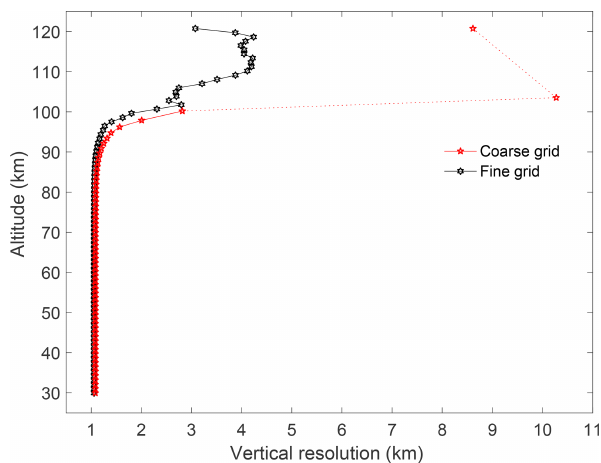
Figure 16. The PCL vertical resolution for 12 May 2012 on the fine and coarse grid. The vertical resolution is similar up to 85km on both grids. Above this height the vertical resolution decreases until it is 10km in resolution above 100km altitude (dotted red line). We consider 100km to be the highest meaningful point on the coarse grid due to large uncertainties above that